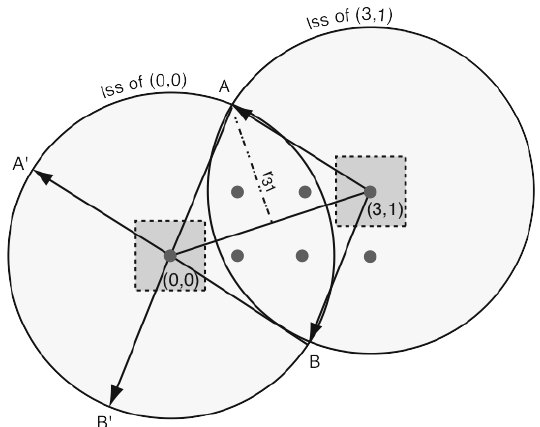
Figure 3. The circles-in-the-sky method is illustrated here in a 2D torus space. The fundamental domain is a square (with a dotted outline), all of the red points are copies of the same observer. The two large circles (which are normally spheres in a three-dimensional space) represent the last scattering surfaces (LSS) centered on two copies of the same observer. One is in position (0,0), its copy is in position (3,1) in the universal covering space. The intersection of the circles is made up of the two points A and B (in three dimensions, this intersection is a circle). The observers (0,0) and (3,1), who see the two points (A,B) from two opposite directions, are equivalent to a unique observer at (0,0) who sees two identical pairs (A,B) and (A 1 ,B 1 ) in different directions. In three dimensions, the pairs of points (A,B) and (A 1 ,B 1 ) become a pair of identical circles, whose radius r 31 depends on the size of the fundamental domain and the topology.